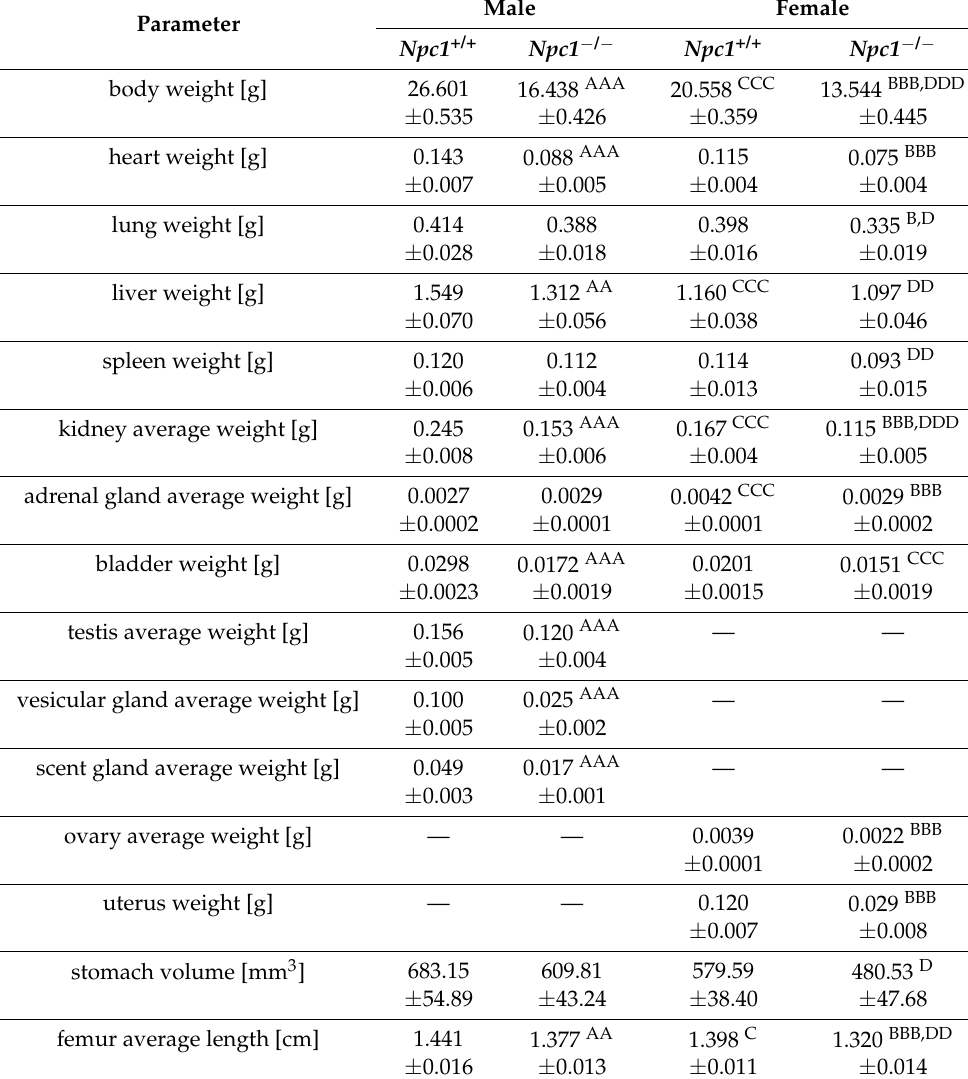
Table 1. Mean values ± SEM of the evaluated parameters of untreated (None groups) male and female Npc1 +/+ and Npc1 − / −